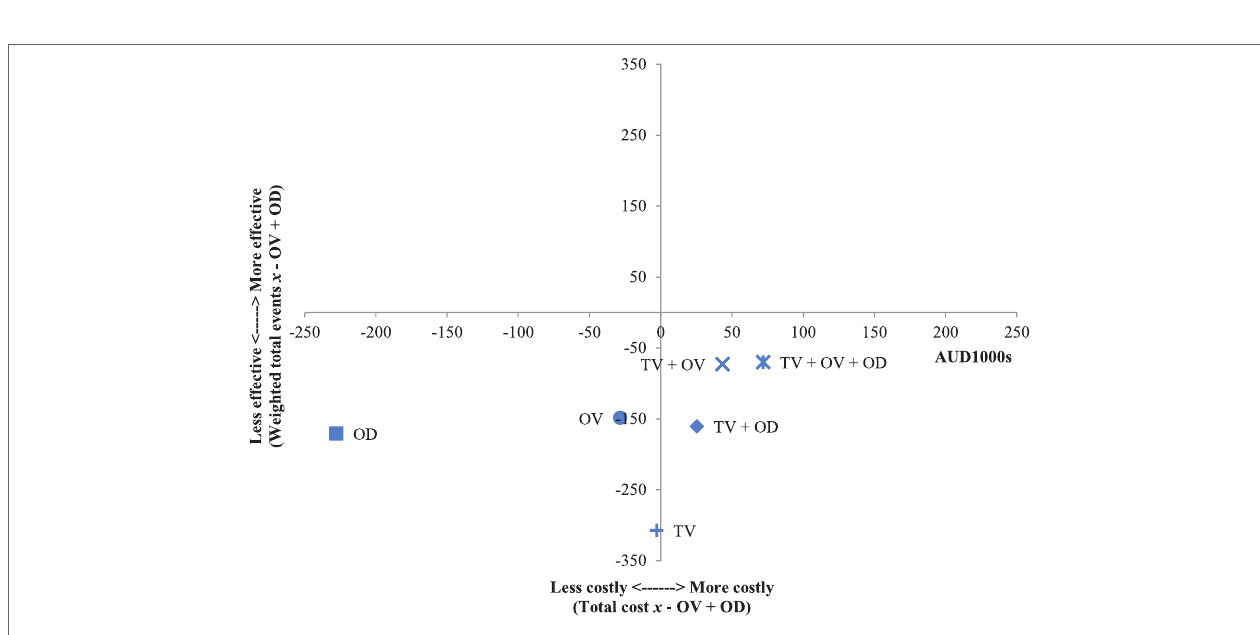
FiguRE 6 | Incremental cost-effectiveness of each format compared with online display (OD) + online video (OV). The cost-effectiveness of OV + OD forms the baseline (cross-section of x and y axes). Effectiveness is weighted total events of each format ( x ) compared with OV + OD. Cost is total costs in AUD1,000s of each format ( x ) compared with OV + OD. Data points that fall in the upper left quadrant represent formats that are more cost-effective than OV + OD.